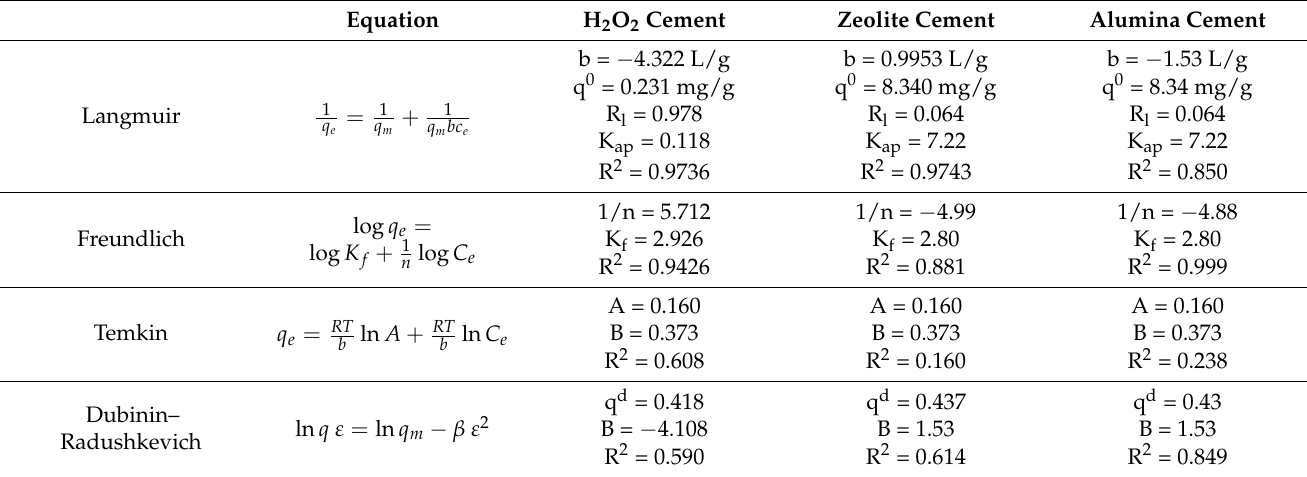
Table 2. Values of different parameters of Langmuir, Freundlich, Temkin, and Dubinin– Radushkevich isotherm.